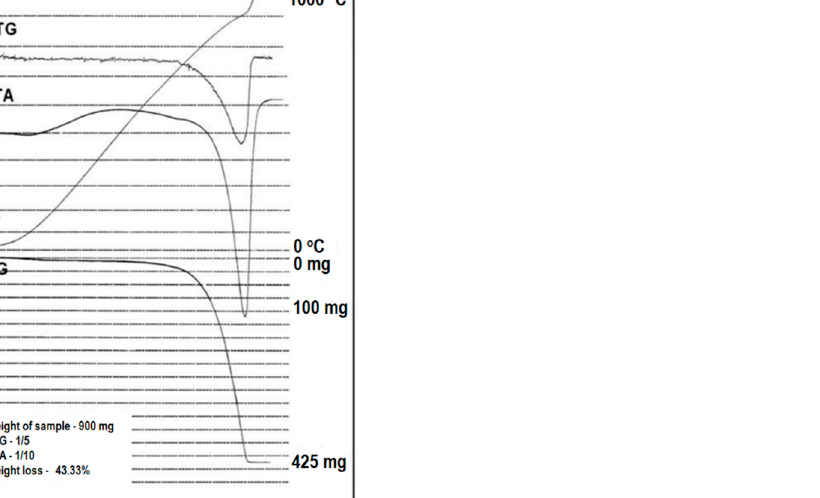
Figure 8. Derivatogram of sample SA2, limestone of the Karchowice Unit taken in the area of Saint Anne Mountain [21].